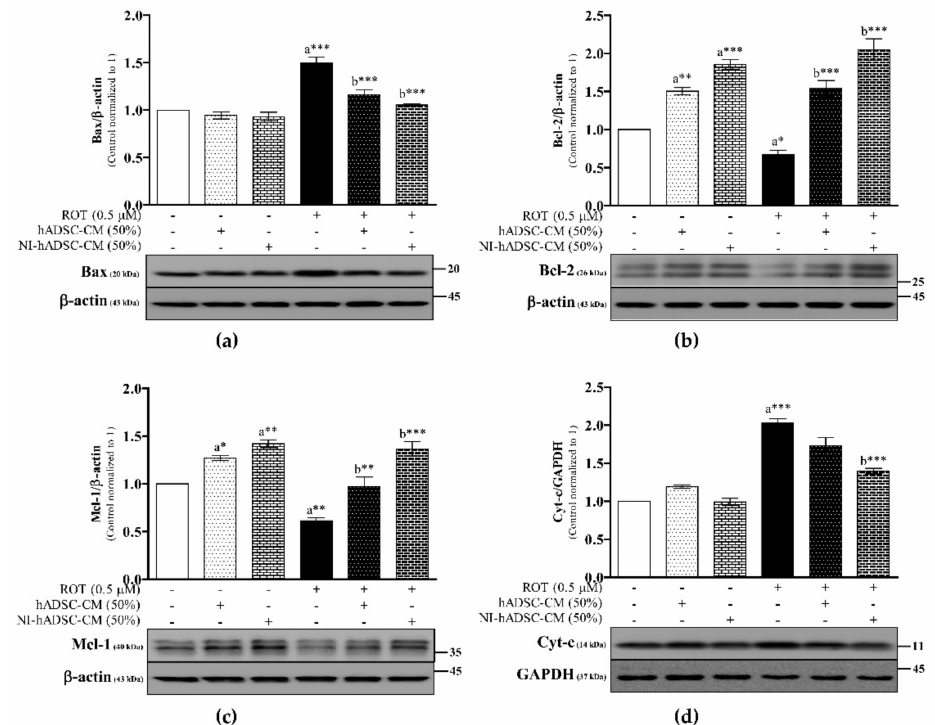
Figure 6. Effects of NI-hADSC-CM against ROT on Bcl-2 family proteins and Cyt-c expressions. SH-SY5Y cells were seeded at a density of 5 × 10 4 cells/mL in DMEM containing 1% FBS and used for experiments after overnight incubation. Cells in the absence or presence of ROT (0.5 µ M) for 48 h were treated with hADSC-CM (50%) or NI-hADSC-CM (50%) during the last 24 h and the Bax ( a ), Bcl-2 ( b ), Mcl-1 ( c ), Cyt-c ( d ) and β -actin or GAPDH expression levels were assessed by Western blotting. Images are representative of three independent experiments. Data are presented as mean ± SEM of three independent experiments. Statistical analysis was performed using one-way analysis of variance (ANOVA) followed by Tukey’s post hoc test. Statistical significance: a—compared with control; b—compared with ROT; * p < 0.05, ** p < 0.01, and *** p <